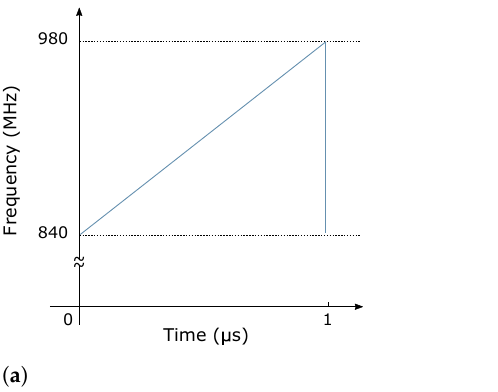
Figure 3. ( a ) Time–frequency representation and ( b ) magnitude spectrum of one single jamming signal cycle. This jamming signal has a sweep period of 1µs, a bandwidth of 140 MHz (840 MHz to 980 MHz) and an amplitude of 250 mV. We also highlight how narrow the LoRa channel bandwidth is (125 kHz) in this context.